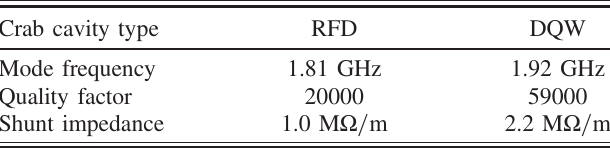
TABLE III. Parameters of the most critical crab cavity HOMs for HL-LHC from numerical